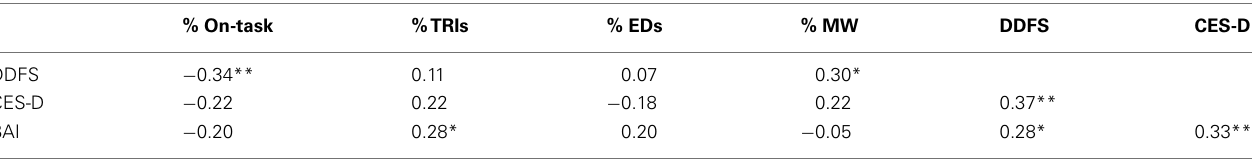
Table 5 | Correlation matrix of Study 1B variables ( N = 64, sample